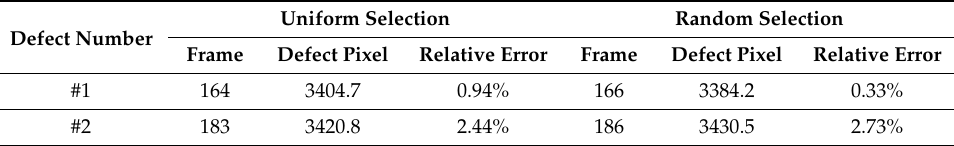
Table 3. Statistics of defect parameters using multiple sensitive regions.